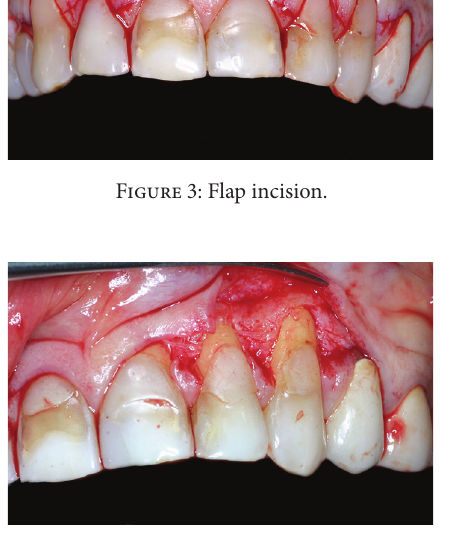
Figure 4: Flap is elevated according to a mixed thickness.